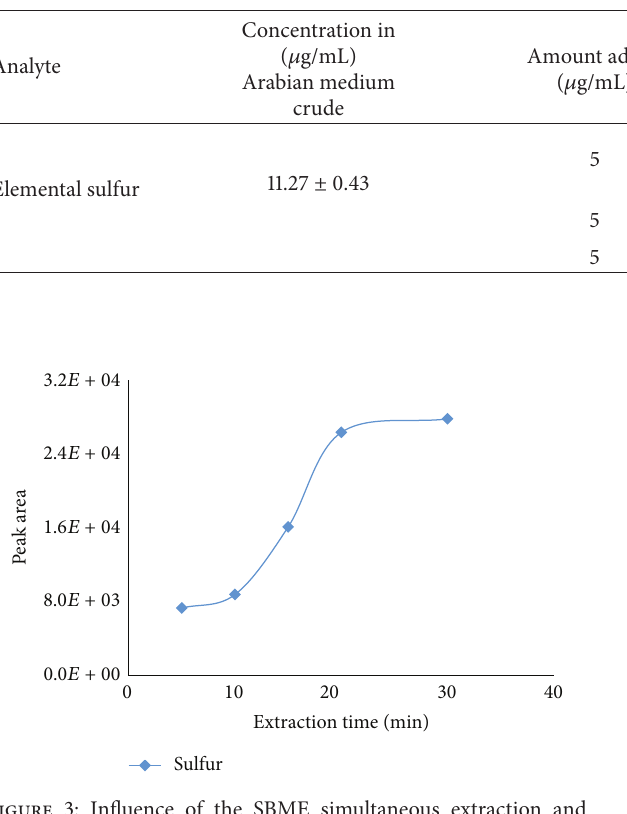
Table 1: Extraction recoveries of elemental sulfur after SBME-GC/MS.